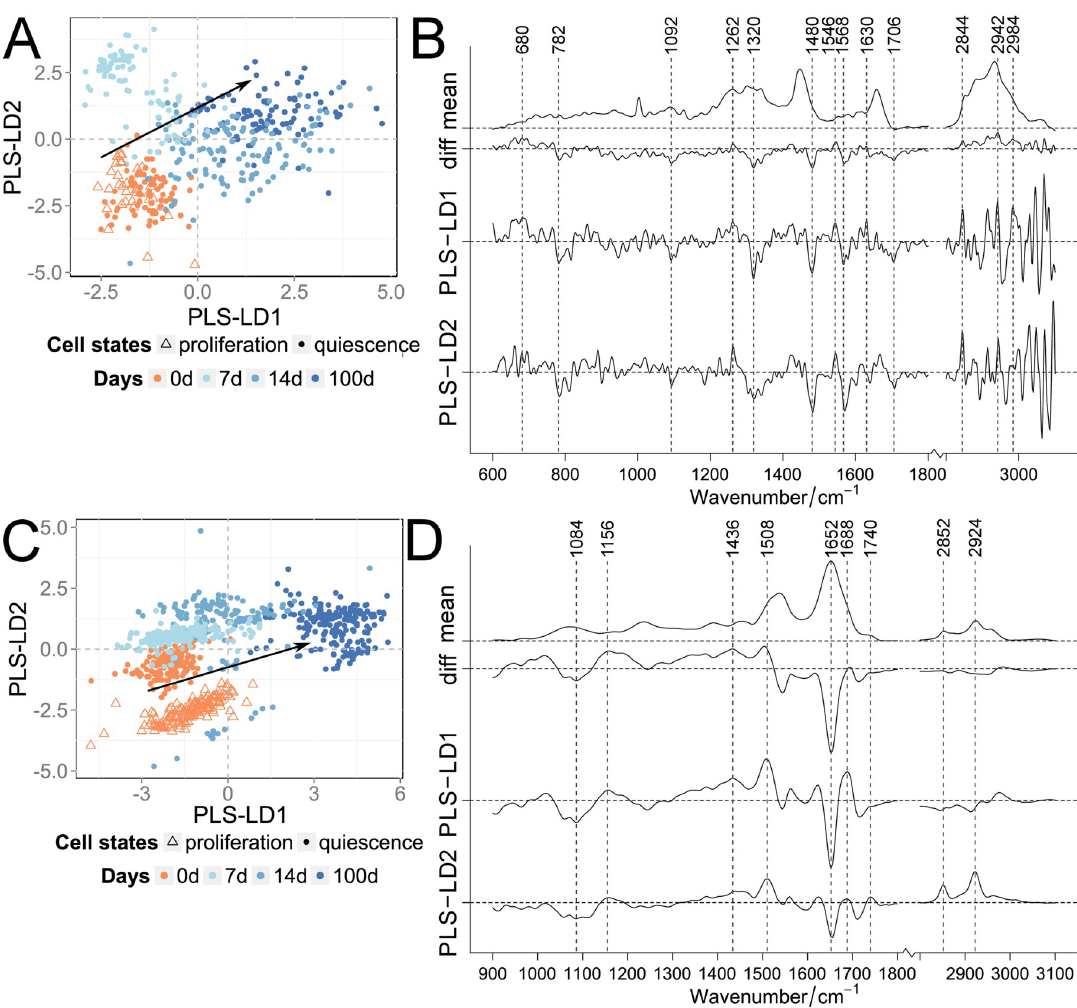
Fig 2. Classification of quiescent cells for the cultivation time. PLS-LDA of Raman (A, B) and FT-IR spectra (C, D) of proliferating and contact-inhibited quiescent cells separated by their cultivation time. Scatter plots (A, C) of proliferating (orange triangle) and quiescent cells after 0 days (orange dots) compared to 7, 14 and 100 days (blue dots; color darkens with increasing time). Arrows indicated the direction of the classified cultivation time. Mean and difference spectra (“diff”, 100 vs. 0 days) from the classified cells are plotted together with the PLS-LD1 and -LD2 coefficients vs. the wavenumber (B,